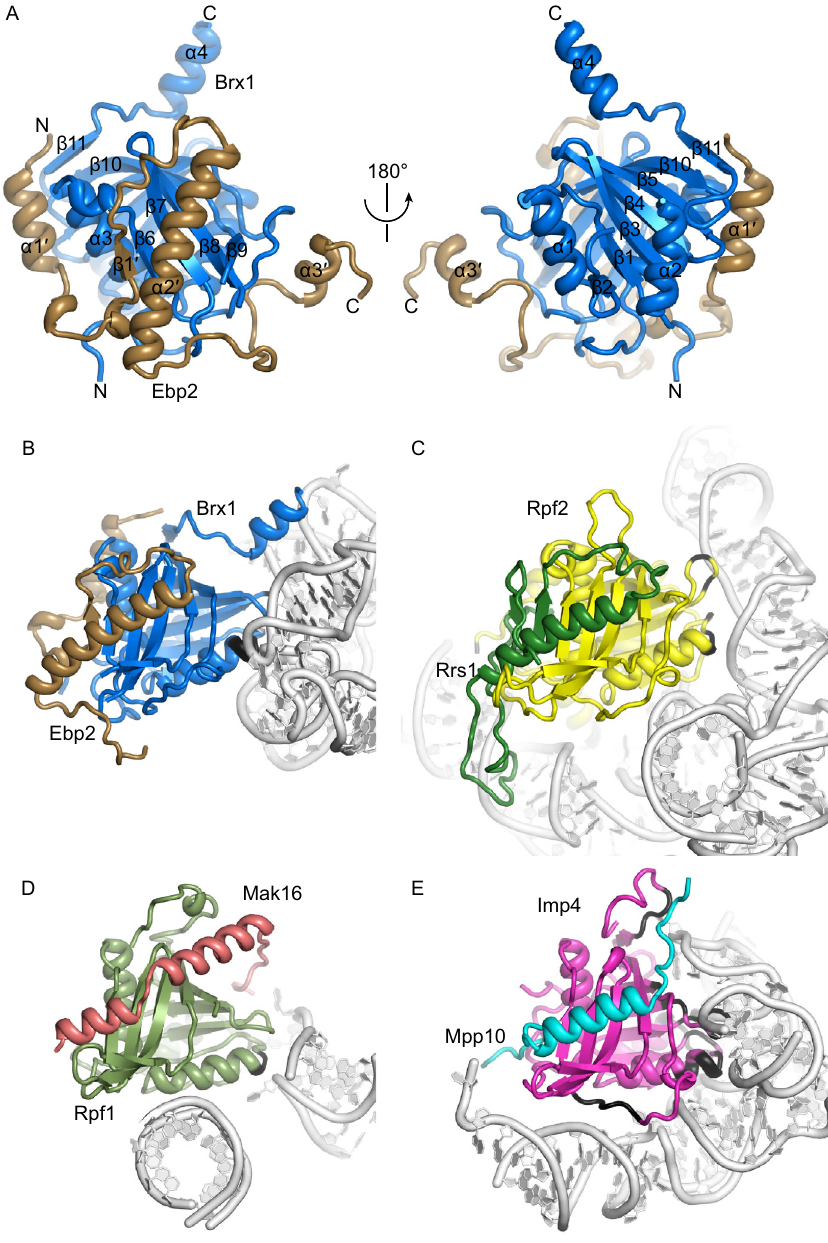
Figure 4. Structure of the Brx1-Ebp2 complex. (A) Crystal structure of the Brx1-Ebp2 complex shown in two opposite views.